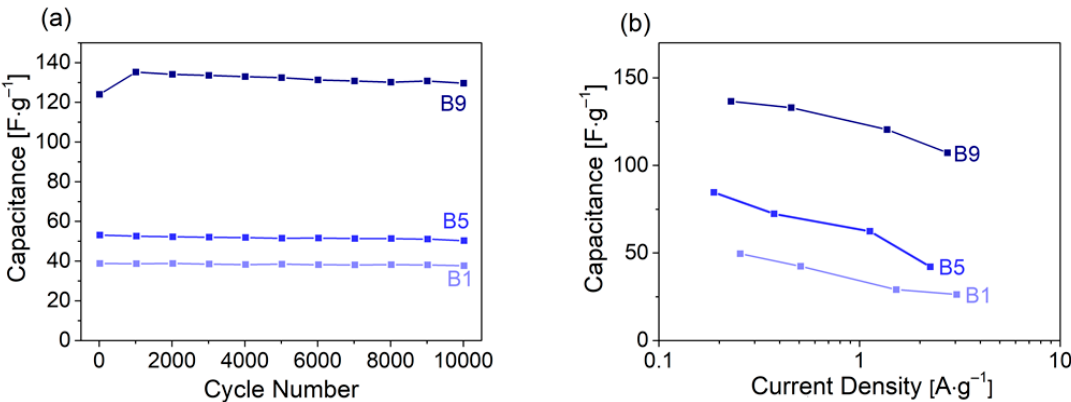
Figure 5. ( a ) Cycling behavior over 10,000 cycles, ( b ) the capacitance retention from galvanostatic cycling of willow bark samples activated with KOH.